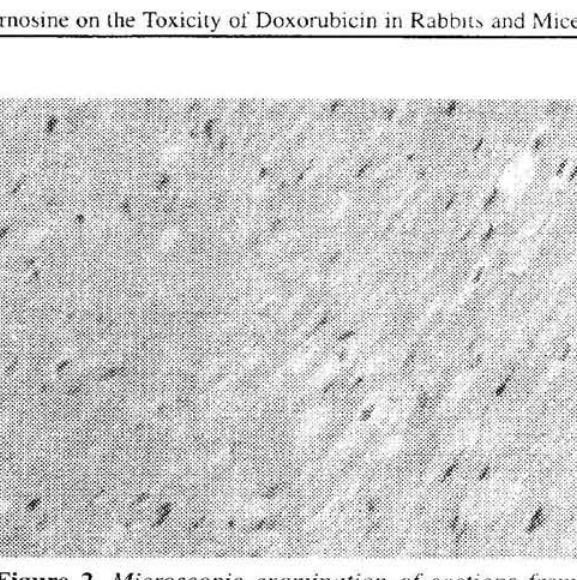
Figure 1. Microscopic examination of sections from rabbit heart after receiving doxorubicin Table 3. presents mean values of MTS for rabbits receiving doxorubicin and doxorubicin with carnosine. Table 3. Microscopic changes in the myocardial mus- cle of the rabbits estimated according to the modified Mean Total Score